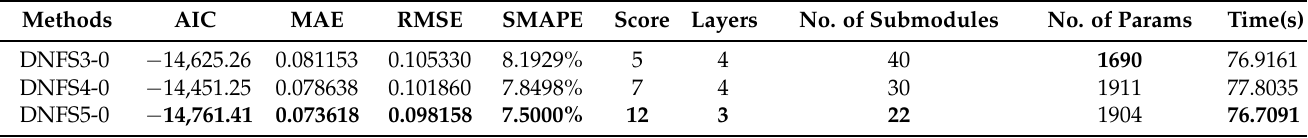
Table 4. The performance of DNFSs with different submodule inputs on Test Dataset No.